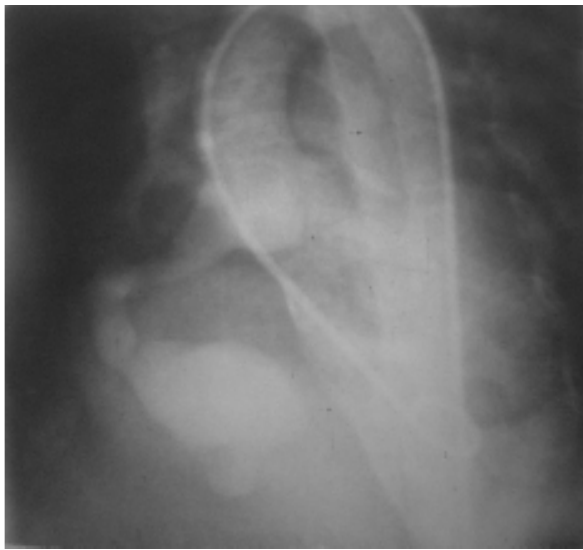
Fig. 2 – Coronariografia do caso 2 mostrando coronária direita dilatada comunicando-se com o seio